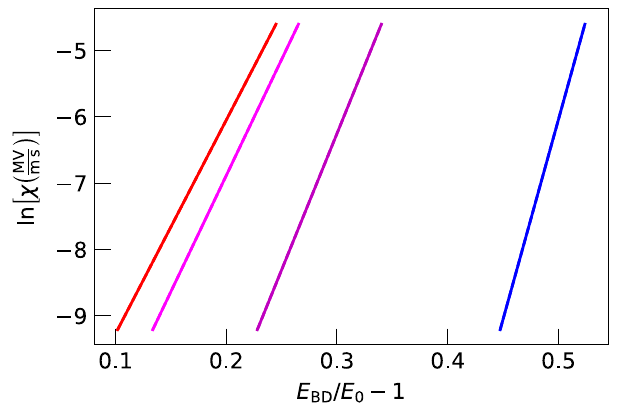
FIG. 17. Logarithm of the field increase rate as a function of =E − 1 , for temperatures of (lines from right to left) 100, E 0 BD 200, 300, and 400 K. Here E is the mean breakdown field, and BD E 180 MV = m [as in Eq. (22)]. The slopes 0 is a reference field of of the lines, from right to left, are 62.3, 41.7, 35.4, and 32.6, which are the values of γ in Eq. (22) for each of the corresponding temperatures.